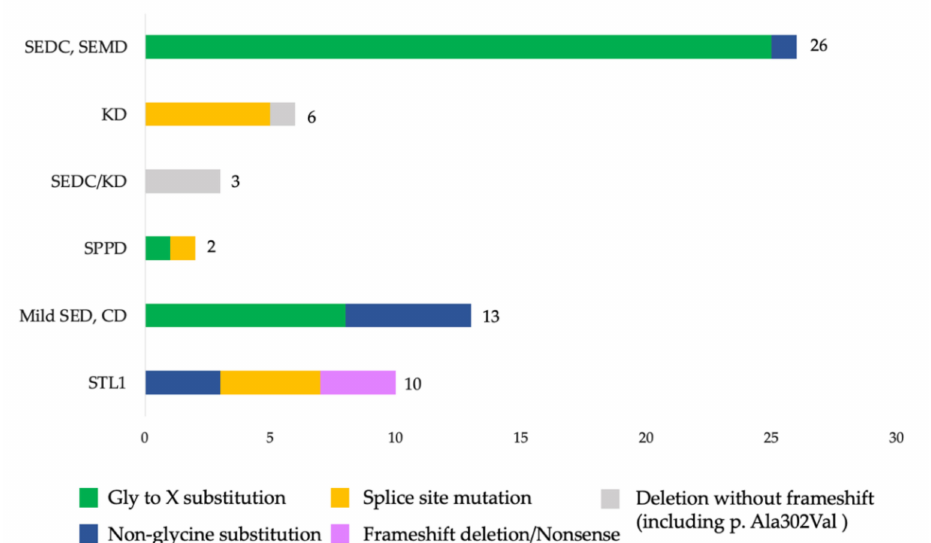
Figure 3. Distribution of various variants in patients with different clinical forms of type II col-